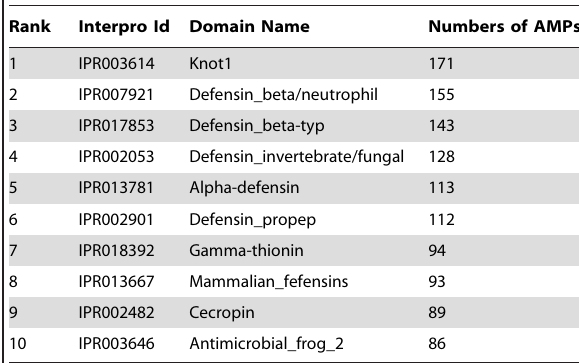
Table 2. Top 10 domains in